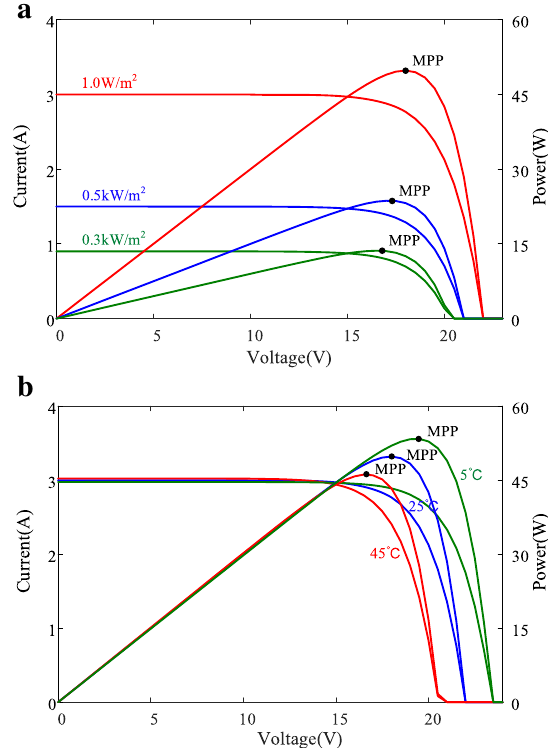
Fig. 2 Output characteristics of solar cells given in Table 1. a Under different irradiance. b Under different